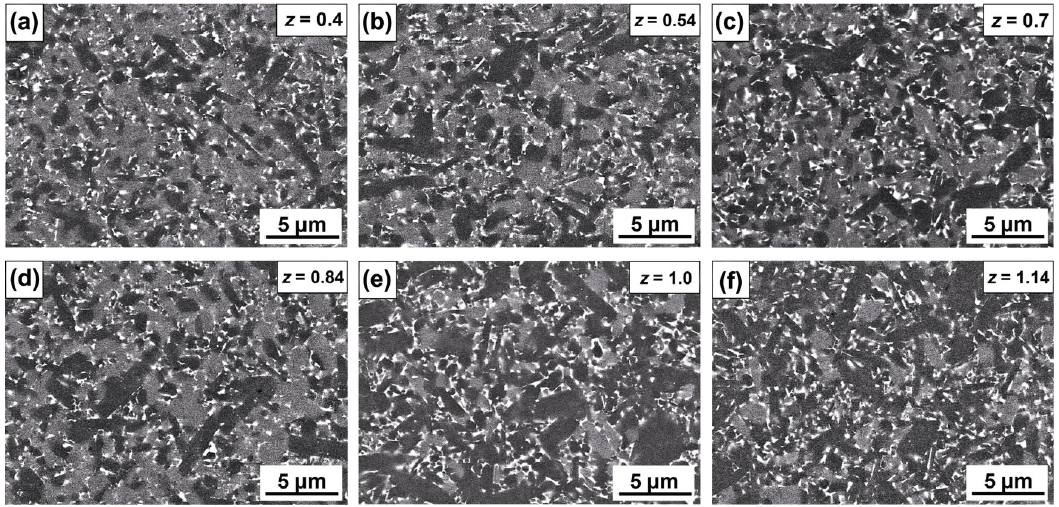
Fig. 5 Microstructure of α / β -SiAlON ceramics with different z values ( m = 1.7, n = 1.0, synthesized at 1750 ℃ ) obtained under SEM–BSE mode: (a) z = 0.4, (b) z = 0.54, (c) z = 0.7, (d) z = 0.84, (e) z =1.0, and (f) z =